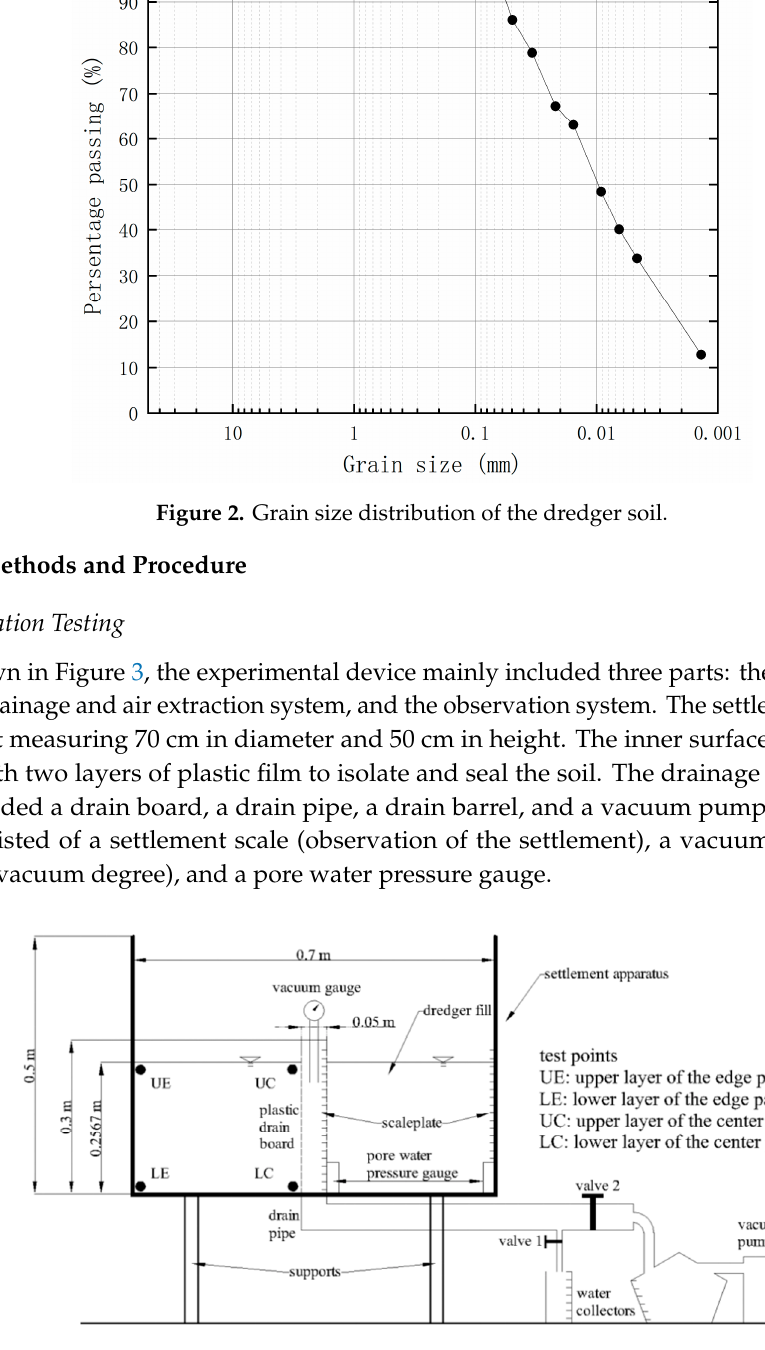
Figure 3. Schematic of the experimental apparatus.